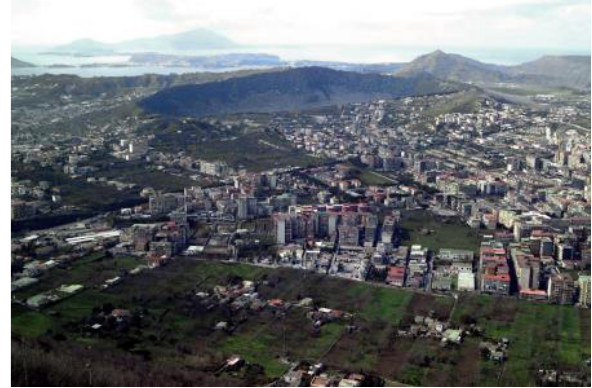
Figure 2. The landscape of Pianura: orography and urbanization